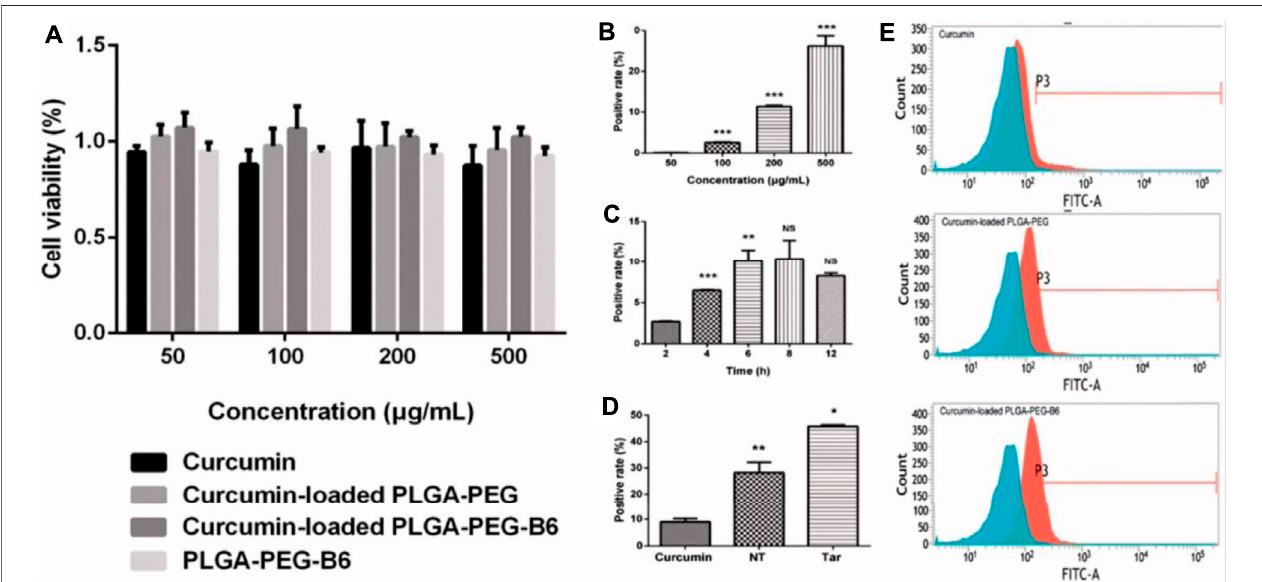
FIGURE9| Cellviabilitiesand cellularuptakeef fi ciency. (A) ResultsofcellviabilitiesbyCCK-8assayafter24-hincubation withconcentrationsof50,100,200,and 500 μ g/ml of Cur, Cur-loaded PLGA-PEG, Cur-loaded PLGA-PEG-B6, and PLGA-PEG-B6, respectively. Cells without treatment were regarded as the control group. Dataasmean±SD, n =3.HT22cellularuptake (B) 50 – 500 μ g/mlCur-loadedPLGA-PEG-B6nanoparticlesat37 ° Cincubationfor4 h. (C) 200 μ g/mlCur-loadedPLGA- PEG-B6 nanoparticles at 37 ° C incubation at different times. (D) 500 μ g/ml Cur, Cur-loaded PLGA-PEG, and Cur-loaded PLGA-PEG-B6 nanoparticles at 37 °